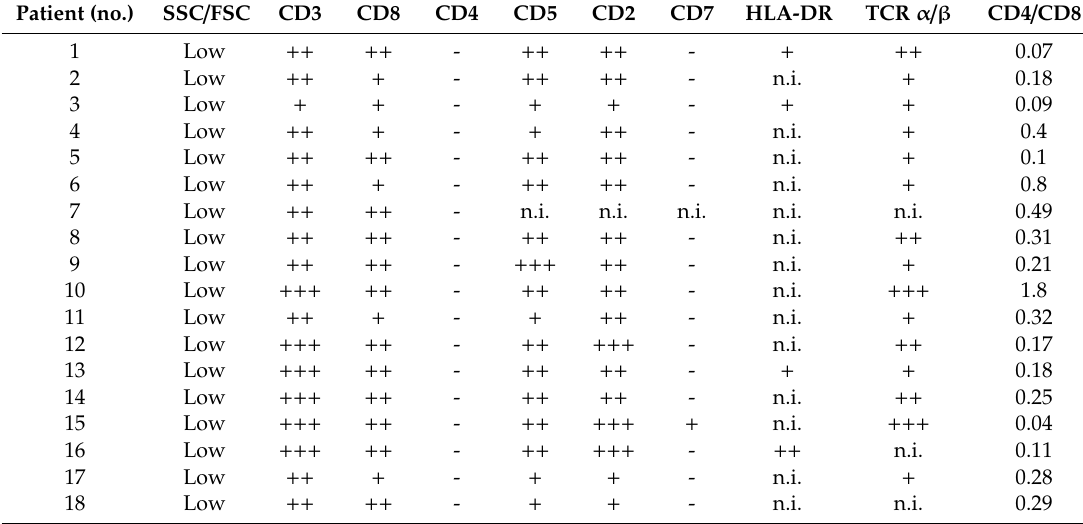
Table 2. Flow cytometric characteristics of the aberrant T-cell population. Scatter characteristics, expression of CD3, CD8, CD4, CD5, CD2, CD7, HLA-DR, T-cell receptor alpha and beta and CD4 / CD8 ratio are depicted for each sample. “ +++ ” indicates strong expression levels, “ ++ ” normal expression, “ + ” weak expression and “-” lack of expression. Abbreviations: n.i., Not investigated. Patient (no.)